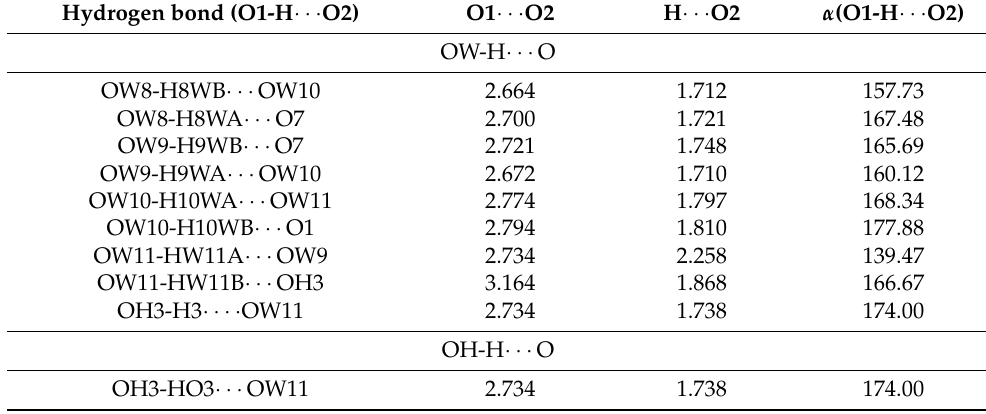
Figure 3. Hydrogen bonding structure in the crystal structure of johannite. ( A ) Hydrogen bonds donated by OW8 and OW9; ( B ) Hydrogen bonds donated by OW10 and OW11. Table 2. Hydrogen bond parameters in johannite (distances are given in Å and angles in